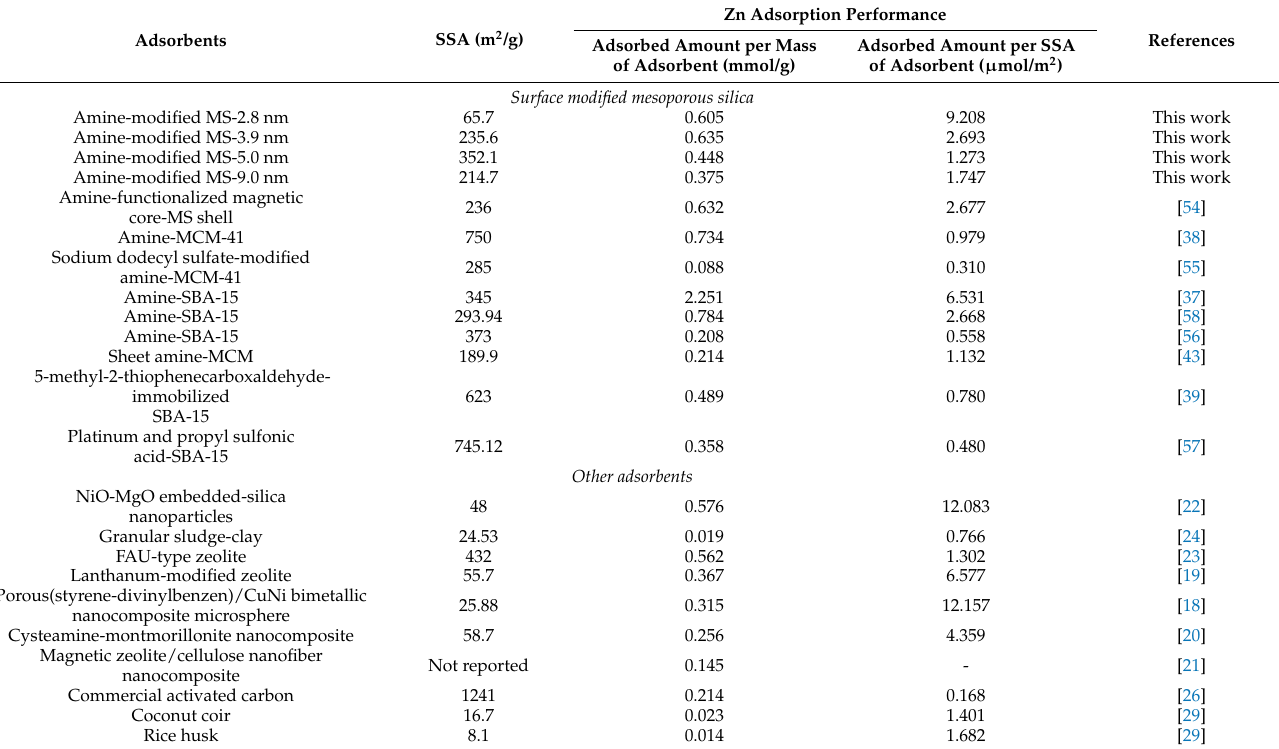
Figure 8. Pseudo second-order kinetic plot for Zn adsorption amount on amine-modified MS with the initial MS pore size of 2.8 nm ( a ), 3.9 nm ( b ), 5 nm ( c ), and 9 nm ( d ) in single-component system at various time intervals in the range of 10–1440 min. Table 3. Comparison of Zn adsorption performance of the amine-modified MSs with other